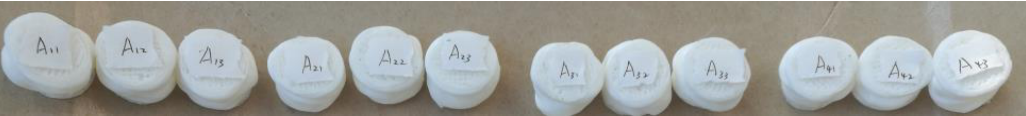
Figure 16. Four sets of experimental parts after compression.